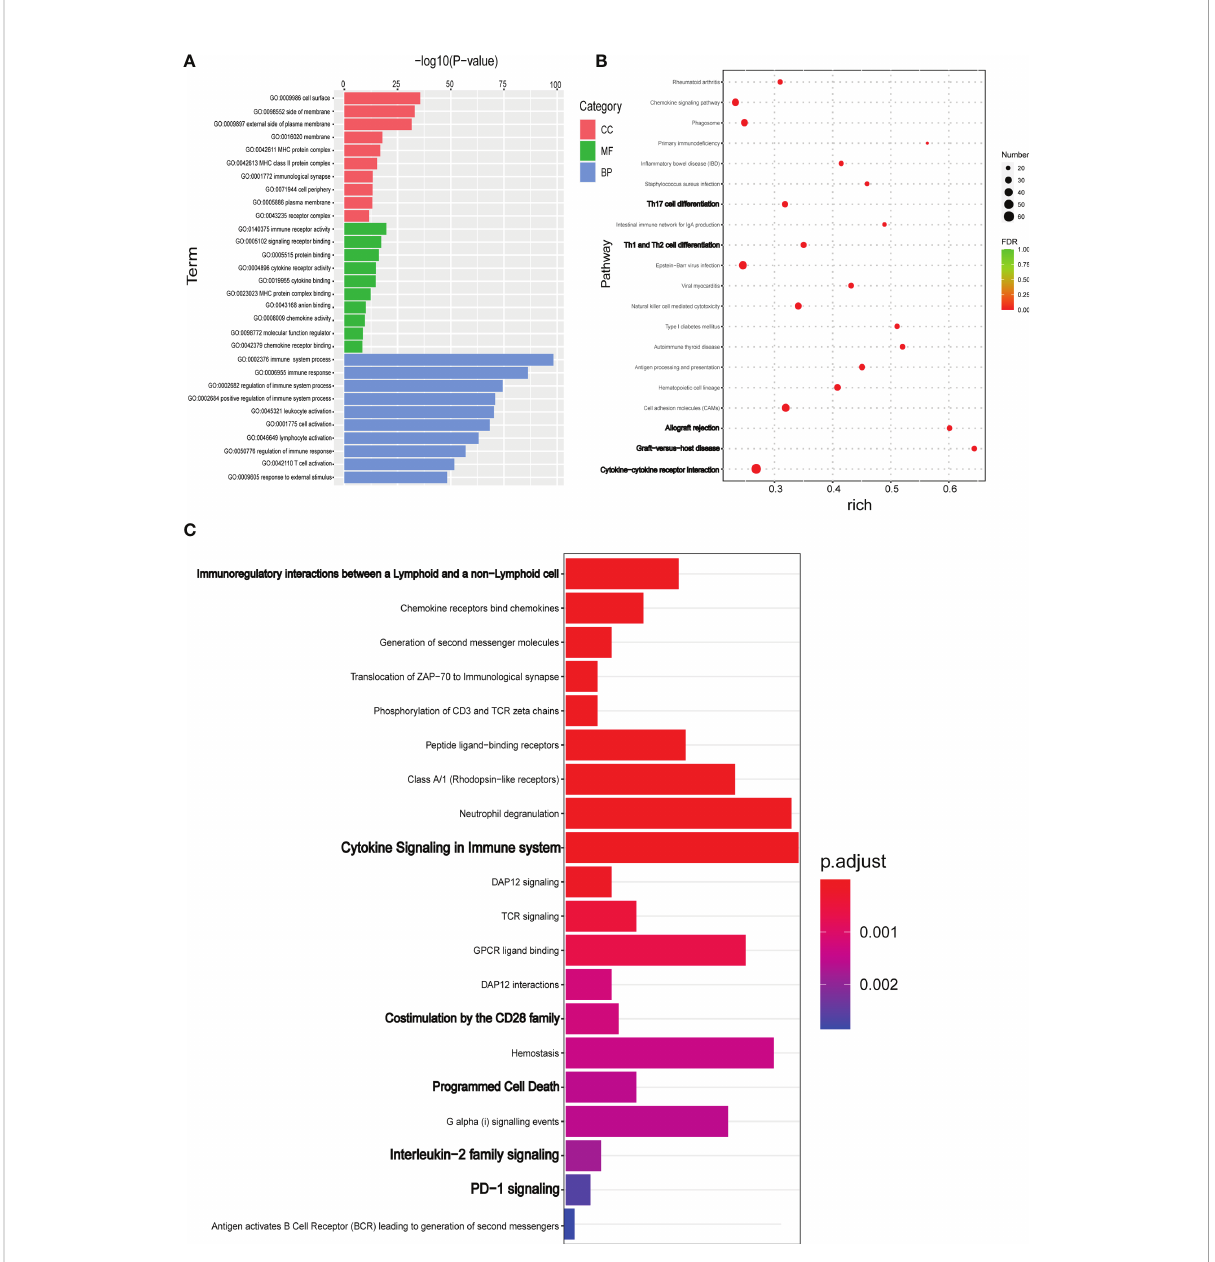
FIGURE 3 DEGs identi fi ed by RNA-seq were evaluated for functional enrichment using multiple gene annotation databases. (A) TopGO was used for GO enrichment analysis. GO enrichment analysis results of DEGs were classi fi ed according to molecular function (MF), biological process (BP) and cell component (CC). The top 10 GO term items with minimum p-value and most signi fi cant enrichment in each GO category were selected. (B) KEGG pathway enrichment analysis of DEGs. According to KEGG enrichment results, the top 20 KEGG pathways with the smallest FDR value, namely the most signi fi cant enrichment, were selected. (C) For the results of Reactome enrichment analysis of DEGs, the top 20 Reactome results with minimum p-value were